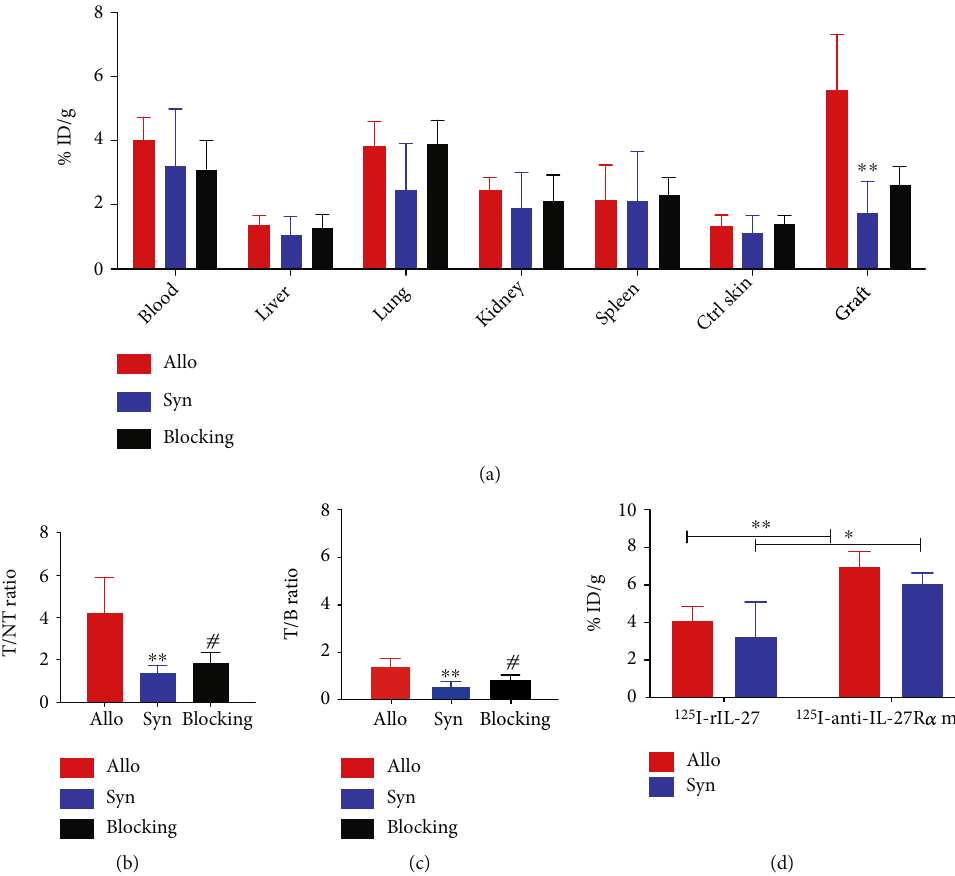
Figure 4: Biodistribution study on day 10 after